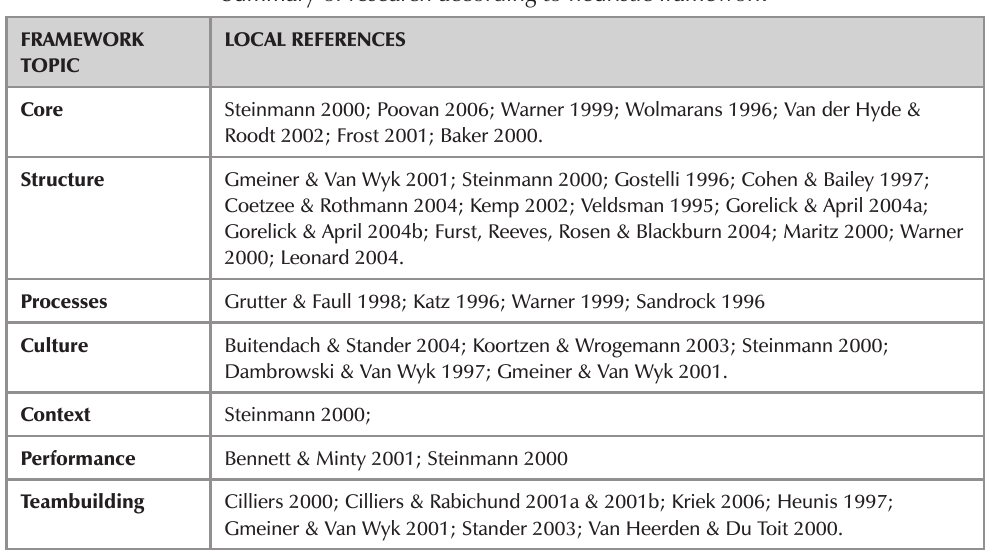
Summary of research according to heuristic